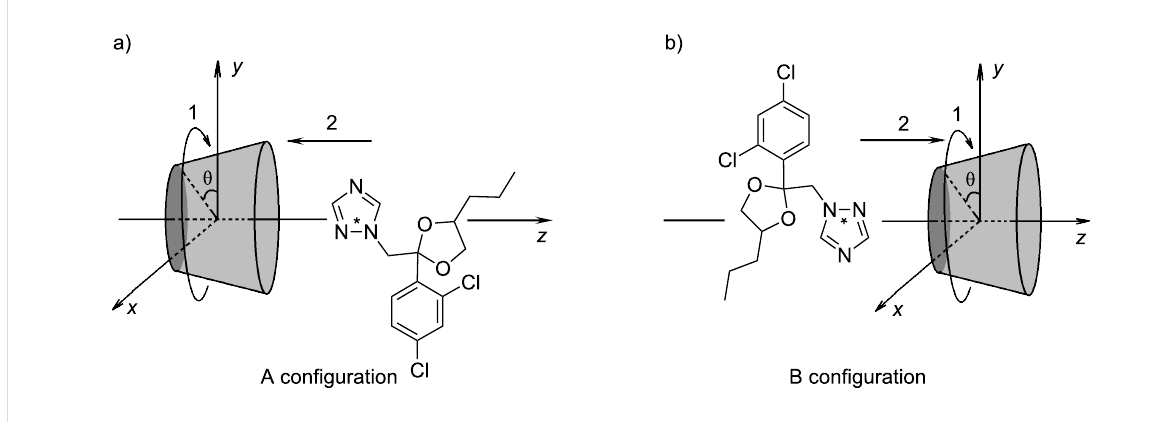
Figure 3: Molecular coordinates used to describe the relative position between the β -CD and guest molecules.